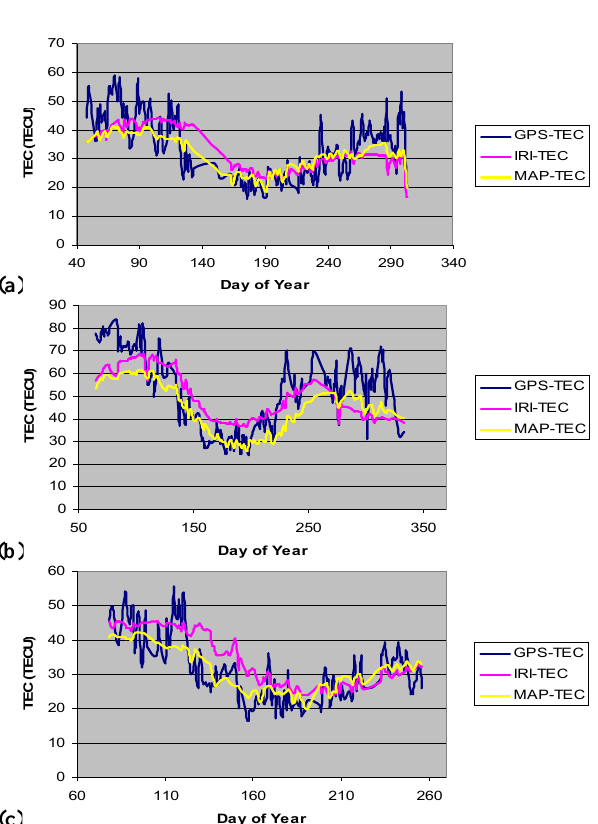
Fig. 8. Comparison of the 10:00UT TEC values for (a) year 2003 at Bloemfontein, (b) year 2002 at Calvinia and (c) year 2003 at